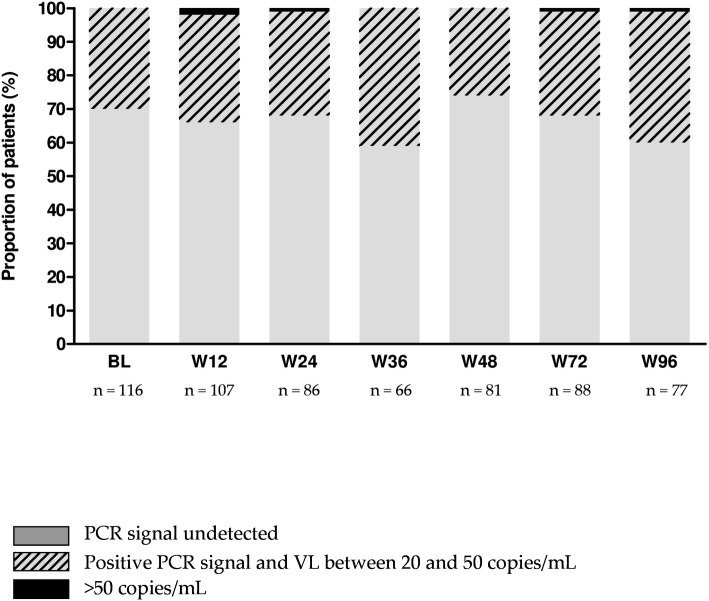
Distribution of plasma HIV-1 viral load at baseline (BL), Week (W)12, W24, W36, W48, W72 and W96.